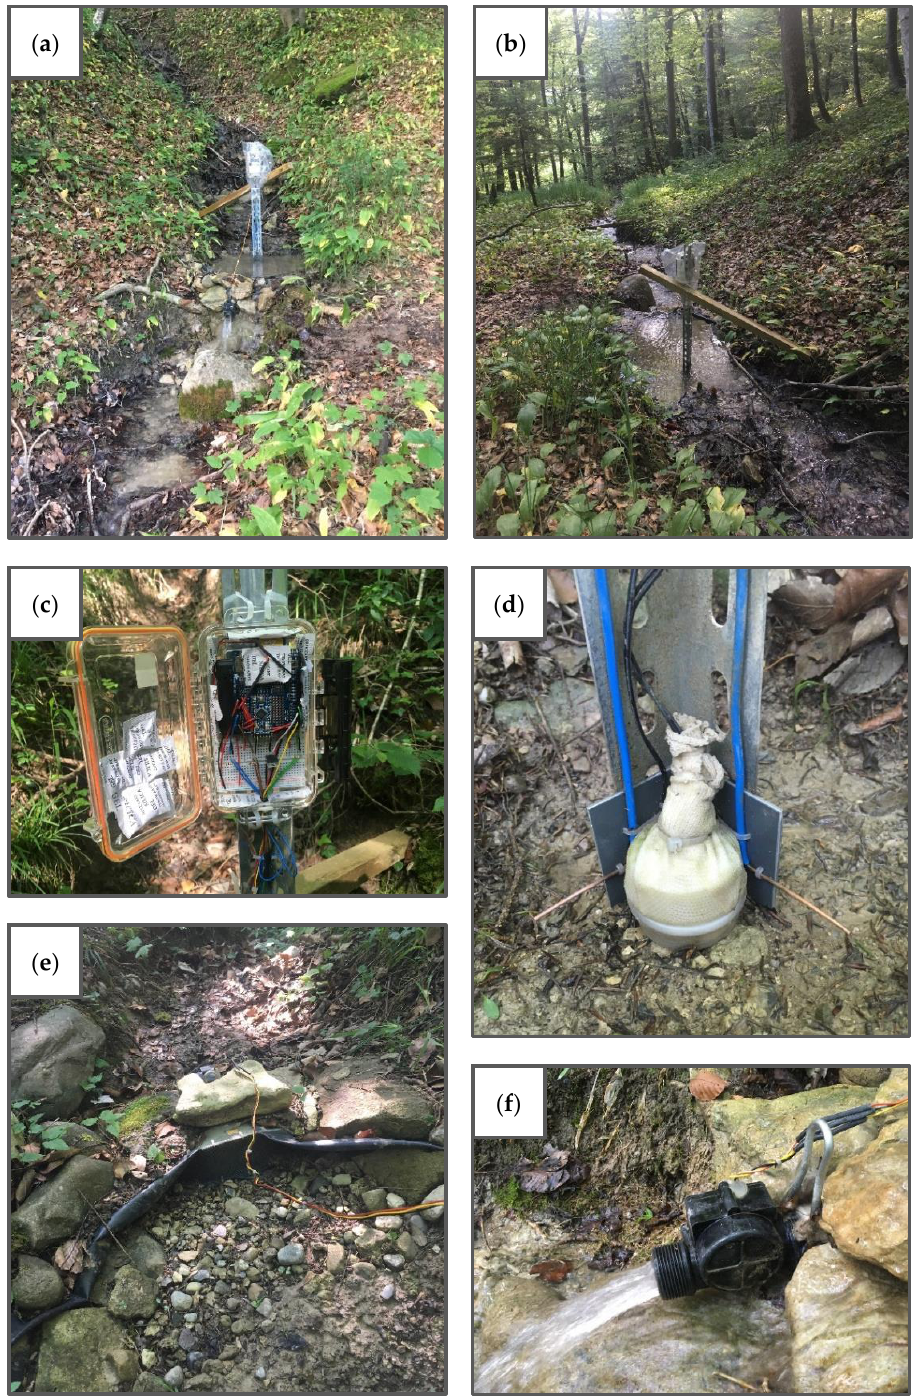
Figure 11. Field setup of the multi-sensor monitoring system (2017 field season): ( a ) upstream view of the monitoring system in a flowing stream, ( b ) downstream view of the monitoring system in a flowing stream, ( c ) the waterproof box, containing the microcontroller board and data logger shield combination, battery pack and MOSFET, attached to the top of the angle bar, ( d ) the ER sensor, float switch sensor (wrapped in a filter sock) and temperature sensor (in a sheltered pocket behind the float switch sensor) attached to the angle bar (using an angled PVC sheet) at streambed level, in a dry stream ( e ) downstream view of the flow sensor setup in a dry stream, including the tarp buried into the channel bed and bank ( f ) the flow sensor during a flow event, and the double legged peg that secures the funnel neck to the channel bed.